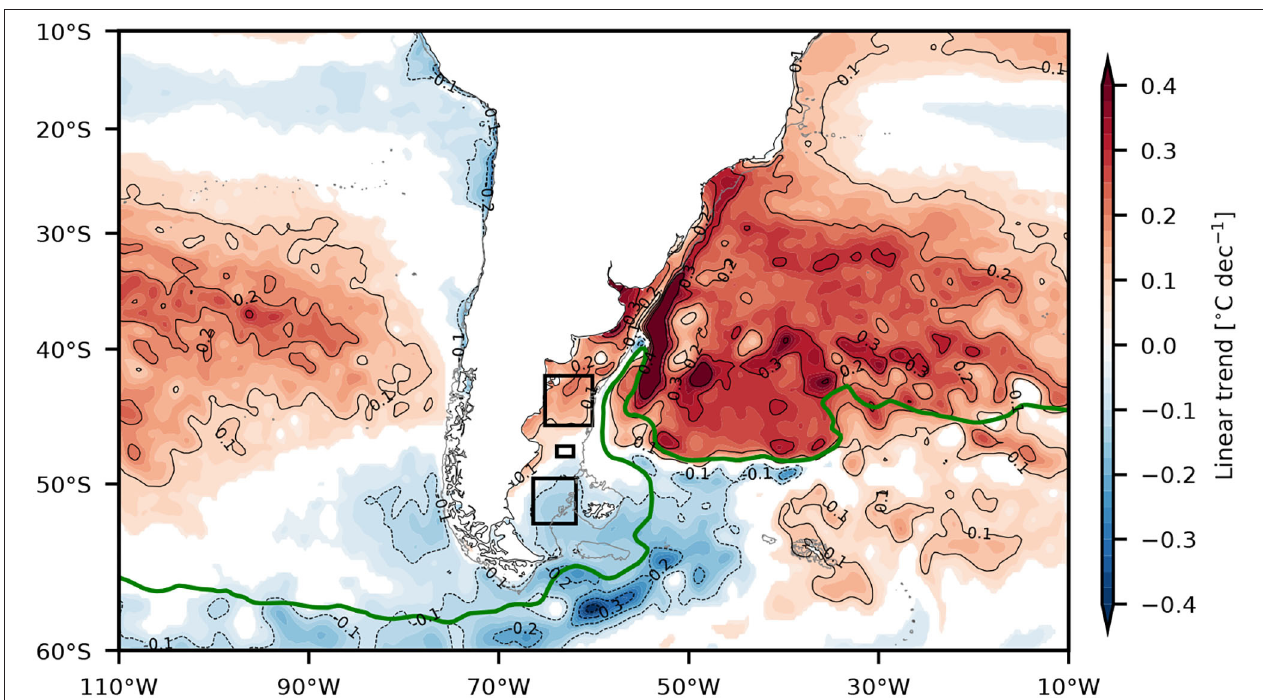
FIGURE 4 | Observational trends of filtered SST anomalies (SSTa) for the 1982–2017 period. SSTa are obtained by subtracting the climatological annual cycle calculated for the same time period from the SST record at each grid point and then smoothed by a 36-month running mean (see Section 2.1). Only regions where trends are significant at a 95% confidence level (after Mann Kendall’s-test) are shaded. Black rectangles indicate the NPS, CPS, and SPS regions (identical to the boxes in Figure 1B ). The solid dark green line represents the mean location of the Subantarctic Front (SAF, Kim and Orsi, 2014).